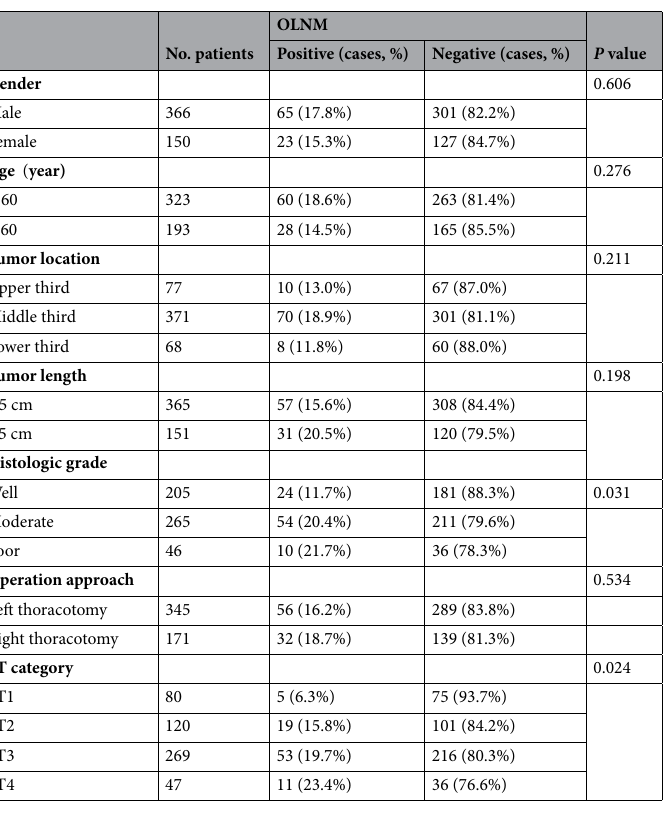
Table 1. Correlation between the clinicopathological features and occult lymph node metastases (n = 516). OLNM occult lymph node metastases.